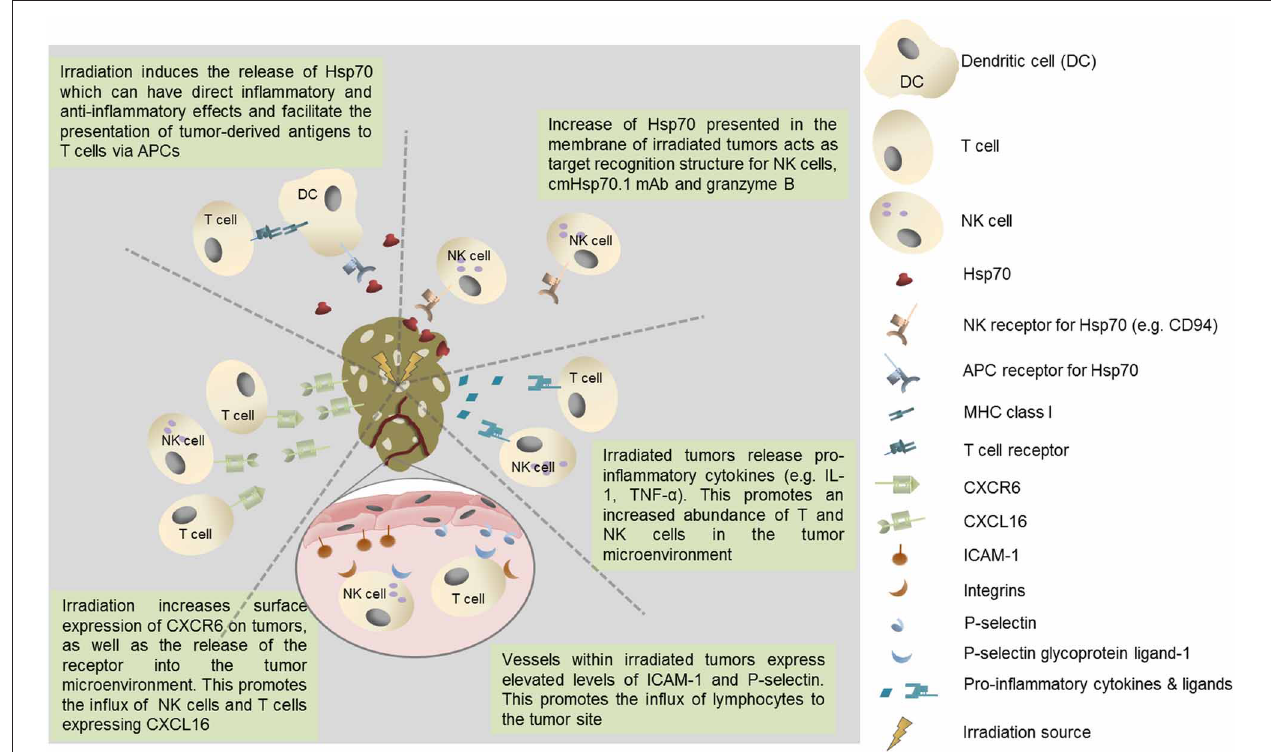
FIGURE 1 | Potential immunological benefits of tumor irradiation. Increased recruitment of immunoregulatory T cell populations could negatively impact on protective anti-tumor immunity.